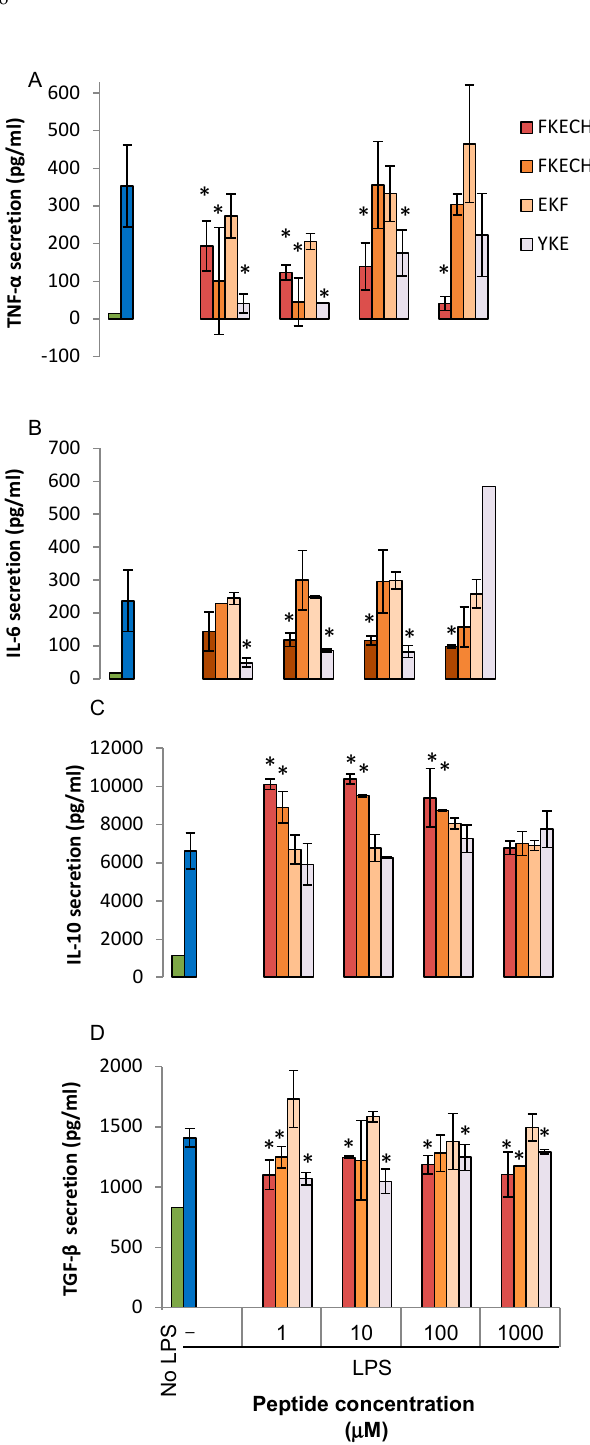
Figure 5. Regulation of LPS-induced cytokine secretion by LfP analogs. U937-derived macrophages were treated with FKECHLA, FKECH, EKF or YKE peptides (1–1000 µ M) for 24 h and then treated with LPS (100 ng / mL, 24 h). Culture media was collected and its cytokine content was determined by standard ELISA for TNF- α ( A ), IL-6 ( B ), IL-10 ( C ) or TGF- β ( D ). Results are representative from three experiments and presented as mean ± SD with biological and analytical duplicates for each treatment. * indicate p < 0.05 compared to treatment with LPS alone. All treatments were statistically di ff erent from untreated cells, except cells treated by LPS and 1 or 10 µ M FKECH in ( A ) (ANOVA).